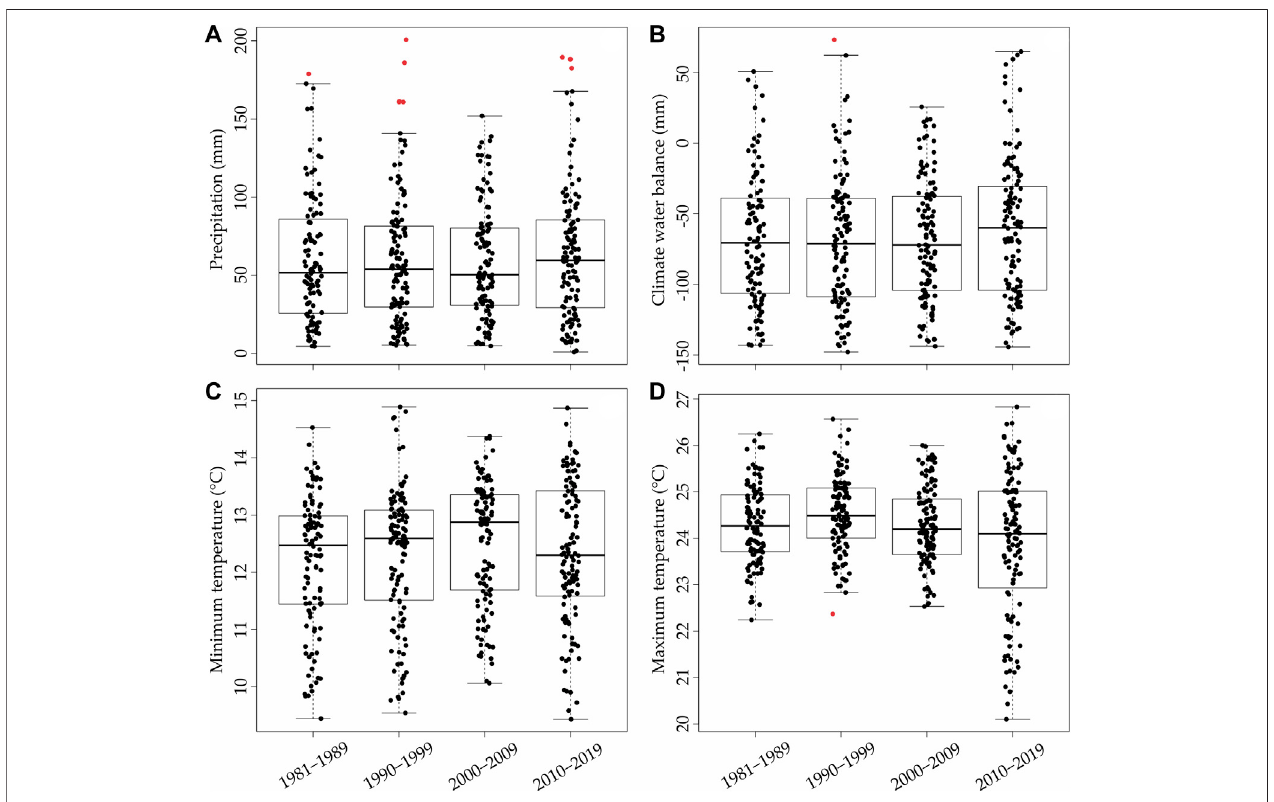
FIGURE3| Historicalprecipitationbehaviorfrom1981to2019 (A) ,climatewaterbalance (B) ,minimumtemperature (C) and maximum temperature (D) ,variables used for SPI and SPEI calculation. Red dots are outliers. Black dots correspond to the data for each parameter for the entire series studied.